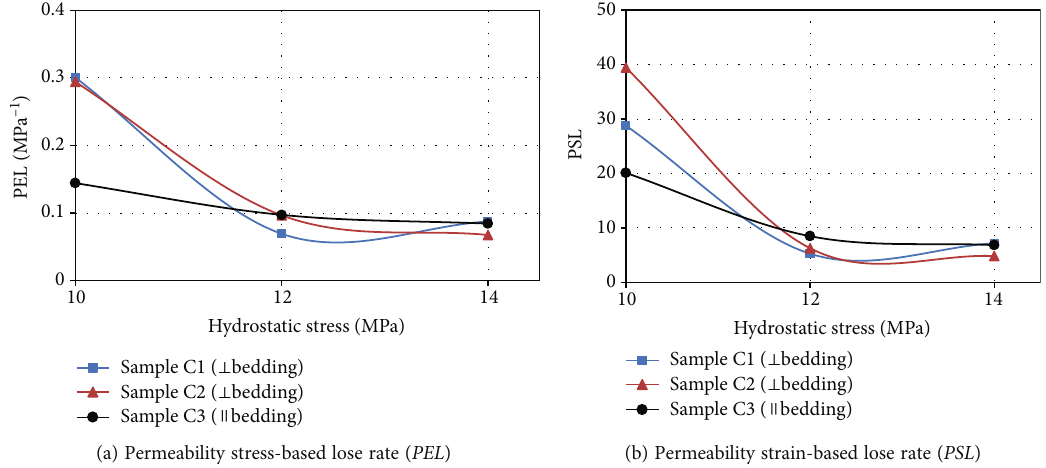
Figure 6: PEL and PSL of coal samples in di ff erent directions under cyclic hydrostatic